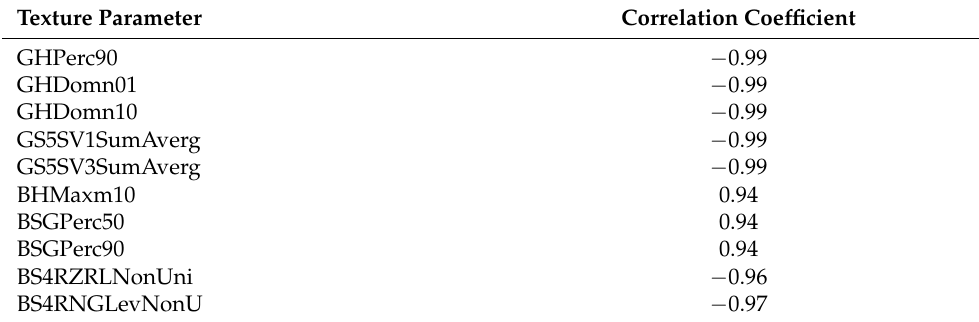
Table 2. Correlation coefficients (R) between lycopene content (mg 100 g − 1 ) and selected image textures from RGB color space for ‘O˙zarowski’, ‘Marvel Striped’, ‘Green Zebra’, Sandoline F1, Cupidissimo F1, and Sacher F1 tomatoes; p <